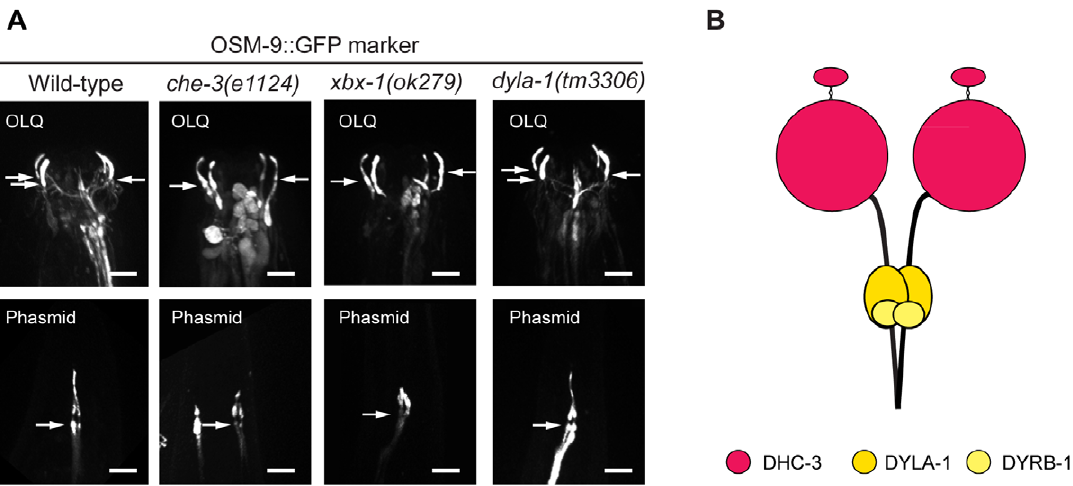
Figure 5. The gross structure of cilia associated with OLQ neurons is independent of conventional IFT-dynein. (A) A ciliary membrane marker, OSM-9::GFP, was used to visualize the structure of cilia of OLQ neurons and of phasmid neurons. Compared to those of wild type, the ciliary structure in mutants of two essential components of conventional dynein, che-3(e1124) and xbx-1(ok279) , is intact in the OLQ neurons, while truncated in the phasmid neurons. The ciliary structure is not grossly perturbed in the dyla-1(tm3306) mutant. The arrows point toward the ciliary base and the horizontal bars represent 5 m m in all panels. (B) A hypothetical new IFT-dynein could exist in C. elegans OLQ neurons.